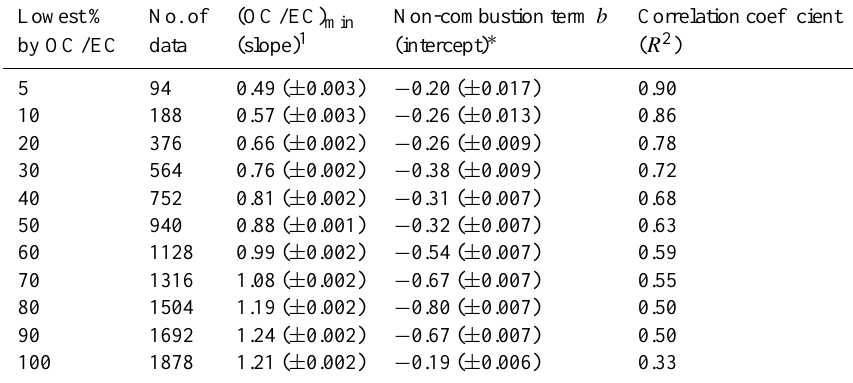
Table 2. Deming regression results of (OC/EC) min using subsets of summer EC and OC data varying from the lowest 5% by OC-to-EC ratio to 100%.